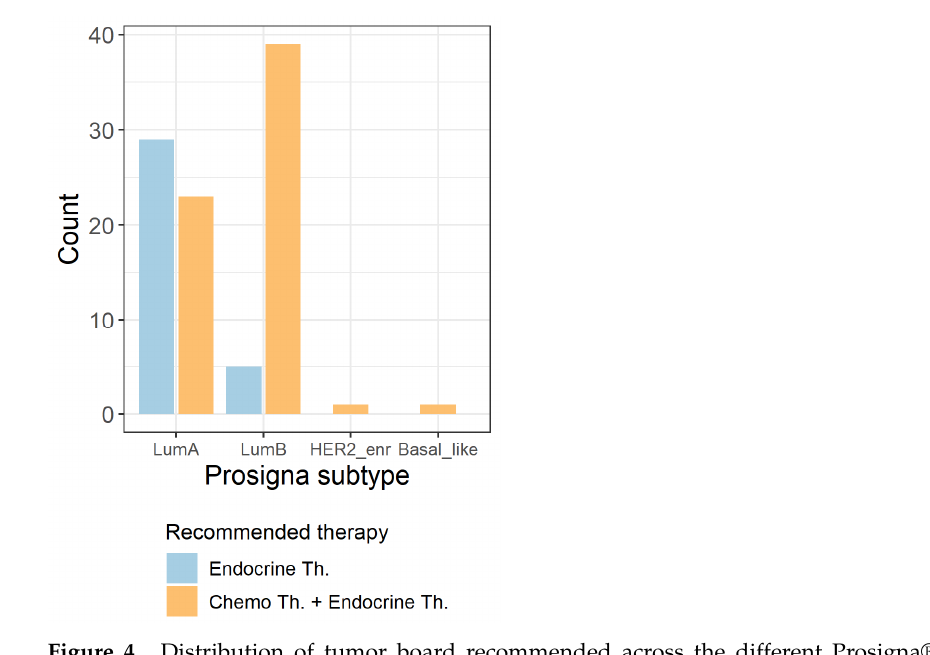
Figure 4. Distribution of tumor board recommended across the different Prosigna® subtypes. HER2_enr = HER2-enriched; LumA = Luminal A; LumB = Luminal B; Th. = therapy.